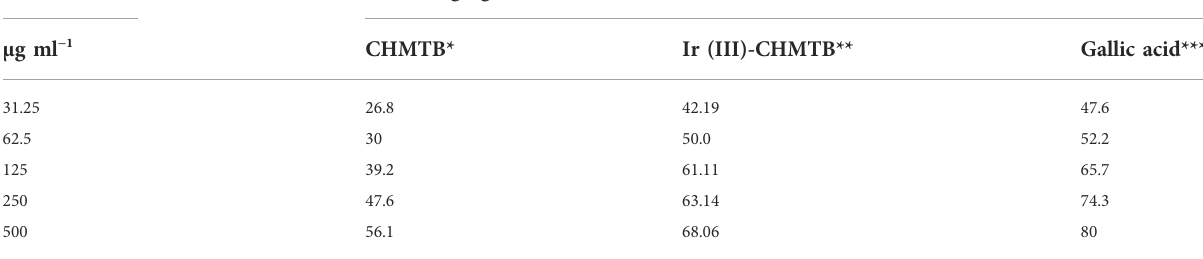
TABLE 10 Antioxidant activity of the studied ligand and its complex in terms of % scavenging activity.